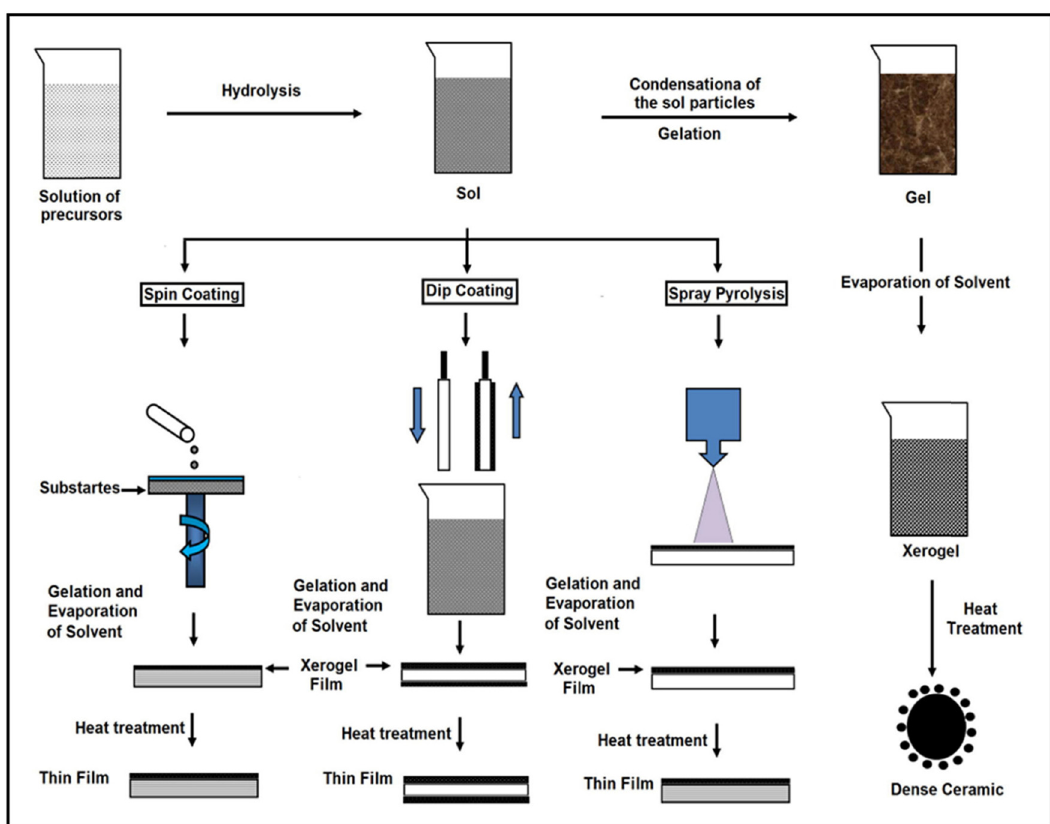
Figure 5: Schematic illustration of the sol – gel techniques [ 72 ] . Copyright 2020, Frontiers.